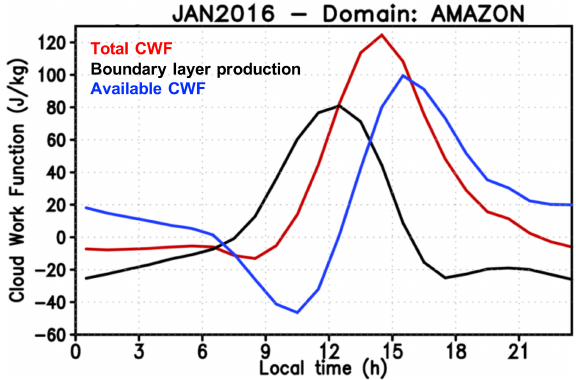
Figure 11. The monthly mean (January 2016) diurnal variation of the total cloud work function (red), boundary layer production (black), and available cloud work function (blue). The curves also represent the areal average over the Amazon